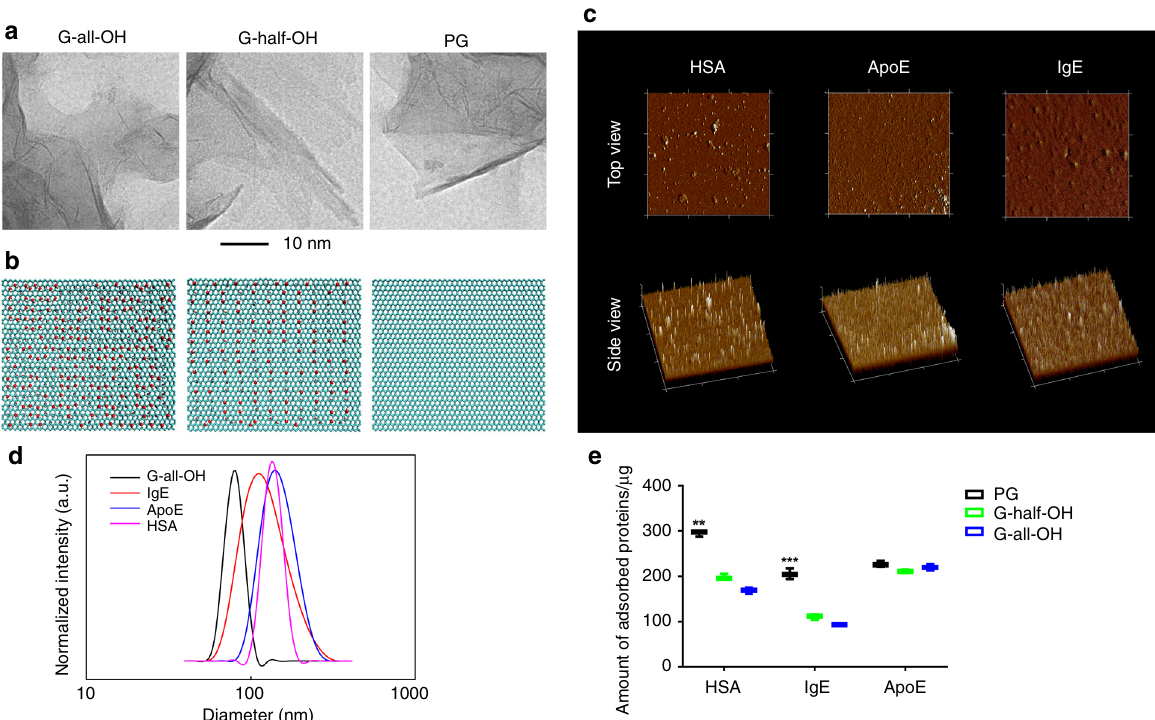
Fig. 1 Structural information of Graphene and derivatives and their in vitro interaction with proteins. a , b Graphene sheet (cyan) with different surface modi fi cations in the experiment and simulation. PG represents the pristine graphene, while G-all-OH stands for the graphene with the hydroxyl groups decorated onto both sides of the whole basal plane, and the hydroxyl groups on G-half-OH was roughly half of that exposed by G-all-OH, respectively. c AFM results of G-all-OH passivated with HSA, ApoE, or IgE, respectively. d Results of DLS showing the size changes post protein adsorption. e In vitro analyses showing the number of proteins adsorbed on the graphene. Data are presented as mean ± s.e.m. ( n = 3). p Values were calculated using multiple t tests (*** p < 0.001, ** p <